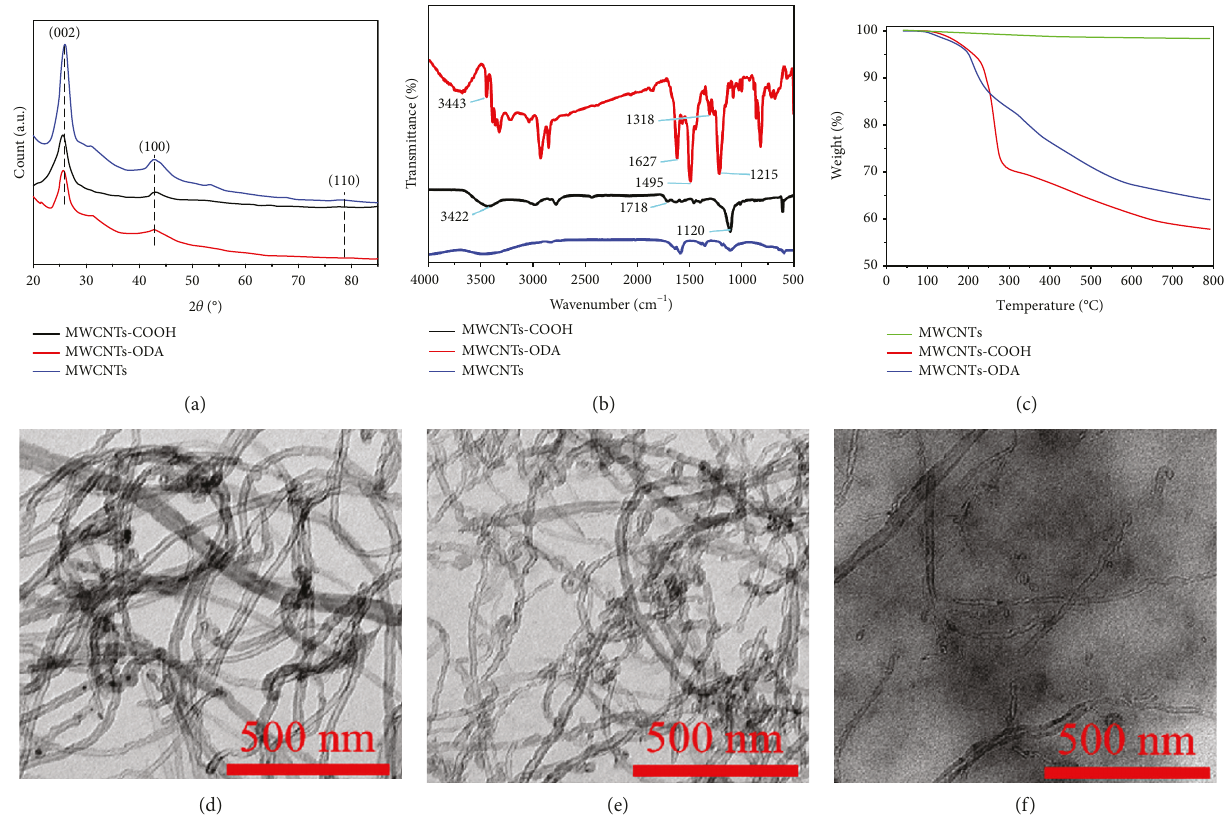
Figure 1: (a) XRD, (b) FTIR, and (c) TGA curves of MWCNTs, MWCNTs-COOH, and MWCNTs-ODA and TEM images of (d) MWCNTs, (e) MWCNTs-COOH, and (f)